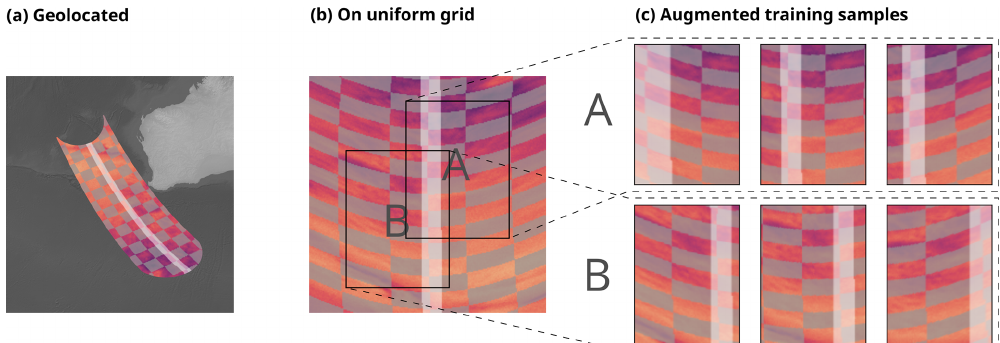
Figure 4. The effect of GMI’s conical viewing geometry on observed features. Panel (a) displays geolocated observations of the 10.6GHz channel (colored background). Grey squares mark equilateral shapes with a side length of 200km oriented along the swath. The highlighted stripe located at the swath center marks the region where the values of the retrieved variables are known. Panel (b) shows the same observa- tions viewed as an image on a uniform grid. Panel (c) shows six synthetically generated training inputs based on two input regions marked in panel (b) . The first row shows three synthetic samples that simulate the effect of viewing the input in region A at a different position across the GMI swath. The second row shows the corresponding transformations for the input in region